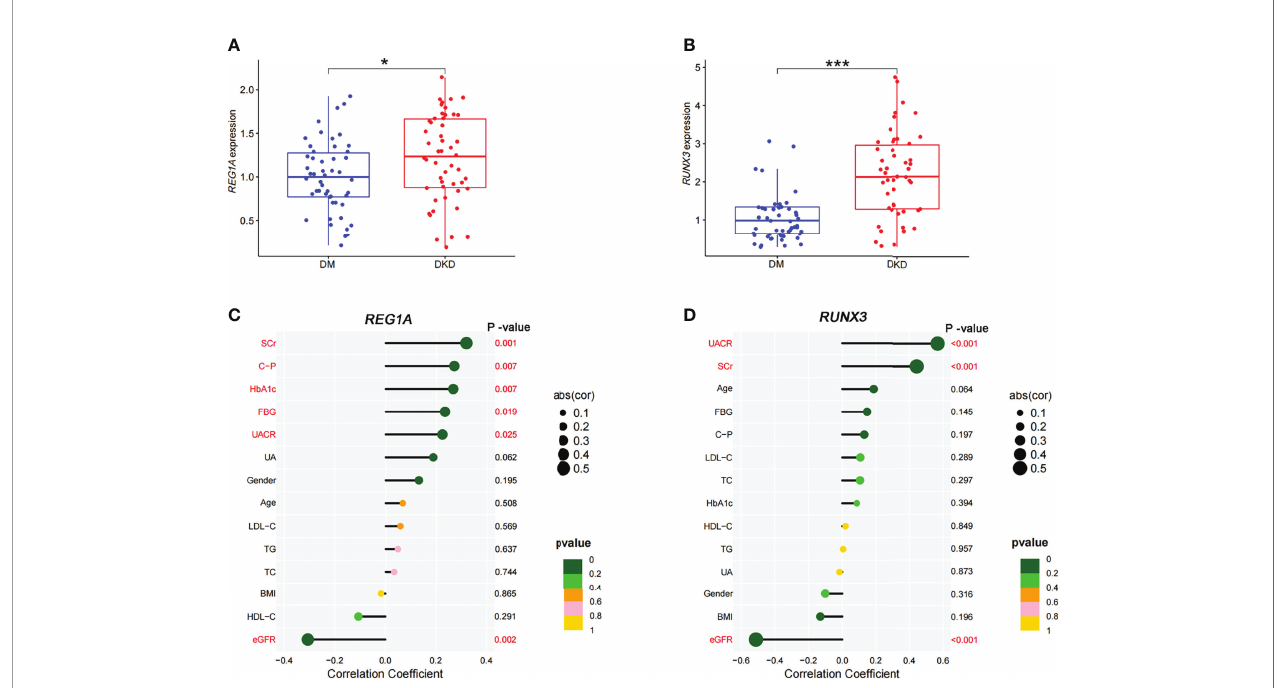
FIGURE 7 | Expression of diagnostic markers and their correlation with clinical characteristics in the DKD and DM cohort. (A, B) Box plots showed signi fi cantly higher expression levels of REG1A and RUNX3 (DKD vs. DM). (C) Correlation of REG1A and clinical characteristics. (D) Correlation of RUNX3 and clinical characteristics. The size of the dots represents the correlation between genes and clinical characteristics; the color of the dots represents the p-value. *p <0.05, ***P